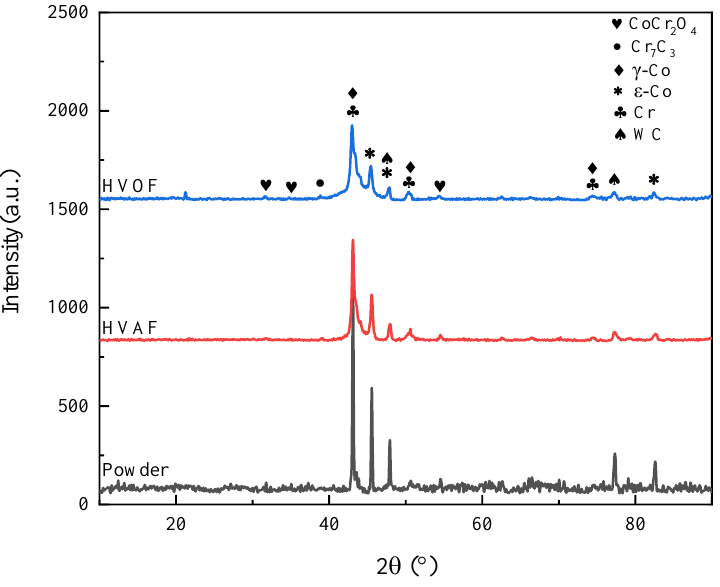
Figure 5. XRD patterns of HVAF and HVOF sprayed coatings.